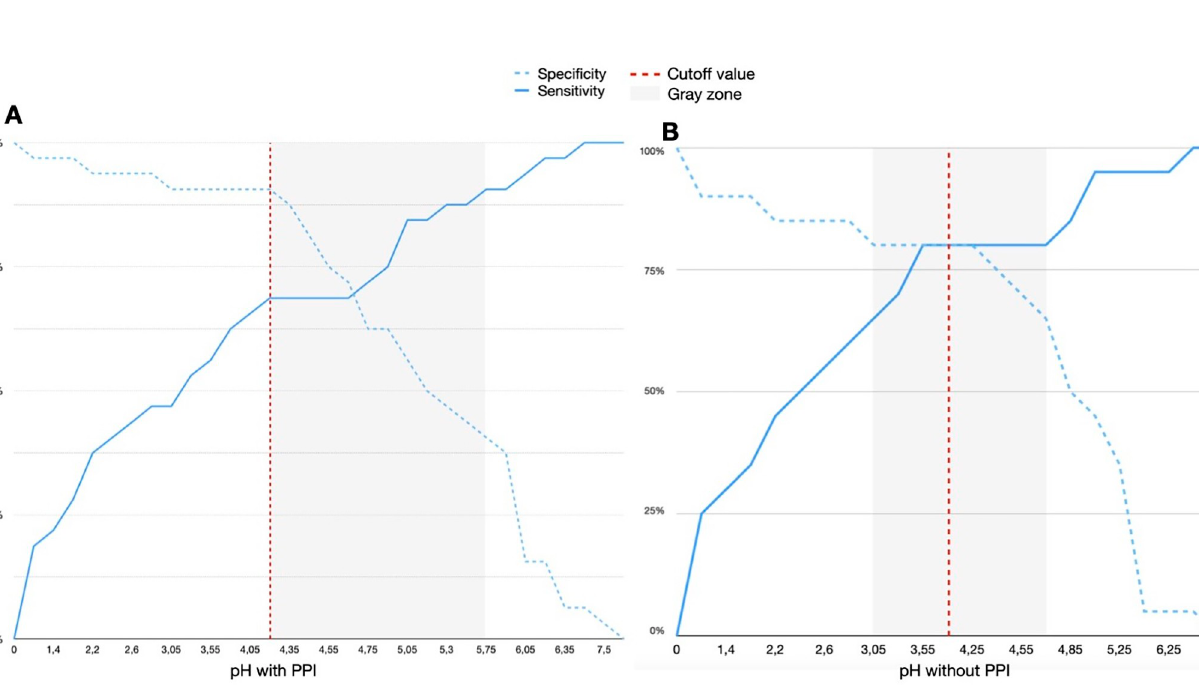
Fig 5. Cumulative distribution analysis of pH detection. Performed to determine the correct NGT gastric placement with ‘Fig 5A’ and without ‘Fig 5B’ PPI use. The red line indicates the cutoff limit according to Youden Index (pH below 4.25 and pH below 3.9, with J = 0.593 and J = 0.6 respectively); the grey zone is shown, with sensibility and specificity of